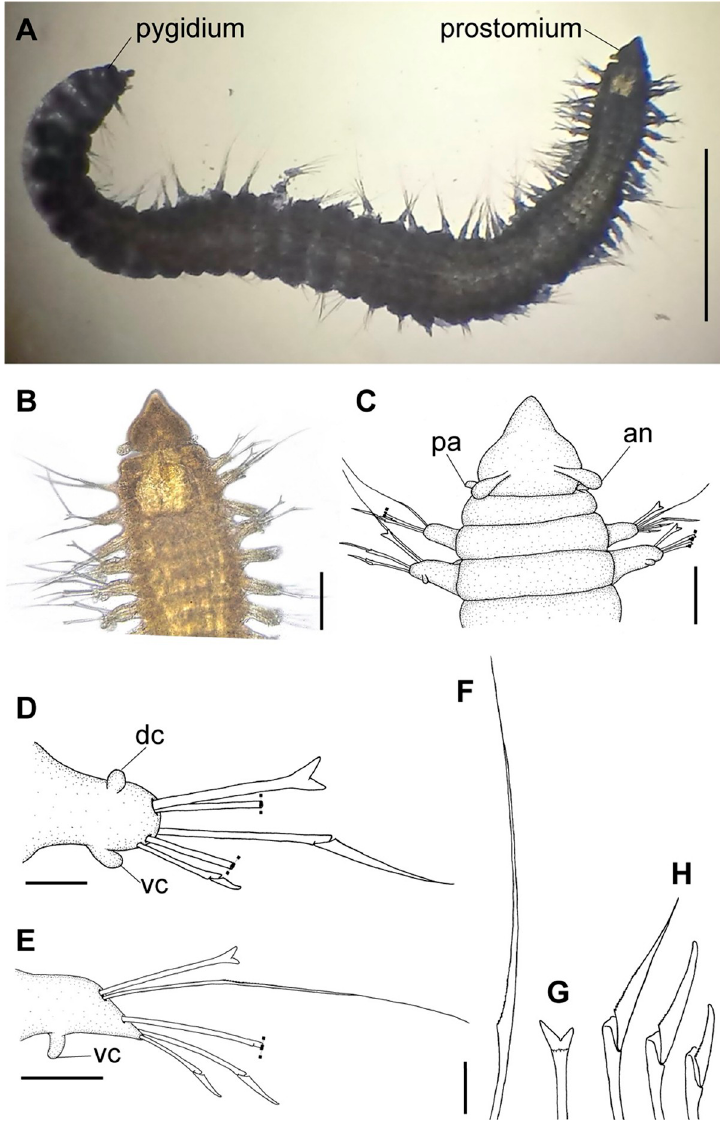
Fig 1. Meiodorvillea minuta (Hartman, 1965), neotype (LACM-AHF Poly 12561). (A) complete specimen, dorsal view; (B,C) anterior region, dorsal view; (D) parapodium 4, anterior view; (E) parapodium 12, anterior view; (F) capillary chaeta; (G) furcate chaeta; (H) compound chaetae. Dash lines represent broken chaeta. Abbreviations: an = antenna; dc = dorsal cirrus; pa = palp; vc = ventral cirrus. Scale bars: (A) = 0.5 mm; (B) = 80 μ m; (C) = 50 μ m; (D) = 20 μ m; (E) = 40 μ m; (F,G,H) = 12.5 μ